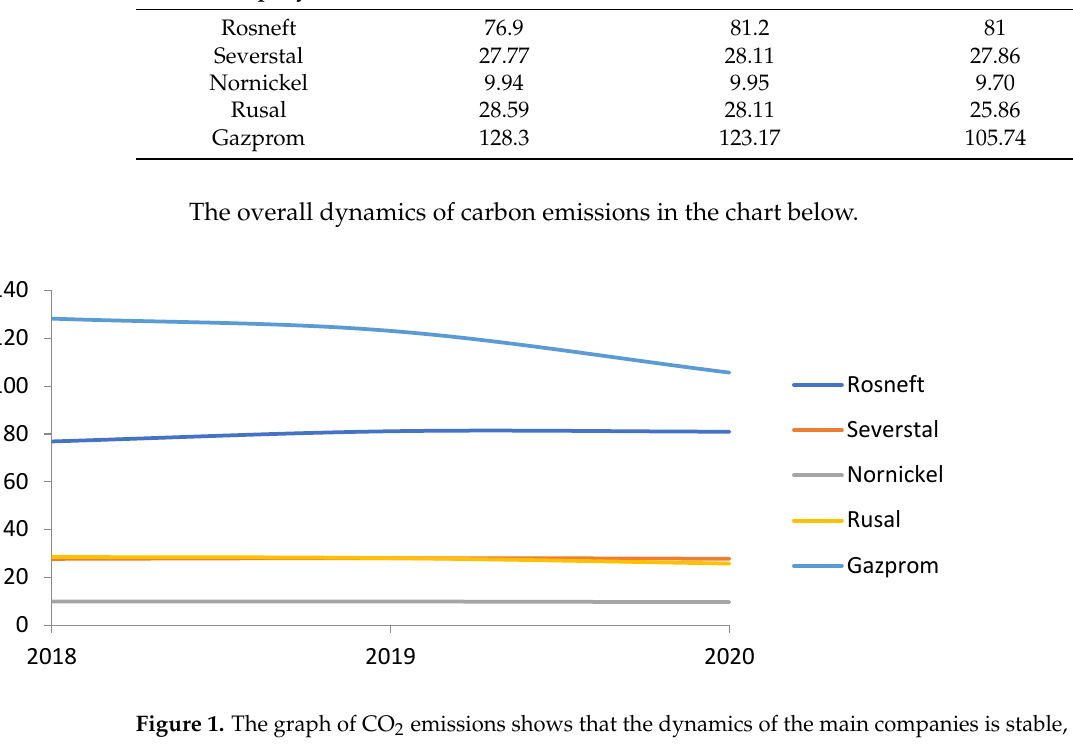
Table 1. Emissions in Scope 1, direct emissions, and Scope 2, indirect emissions, mln t. Company